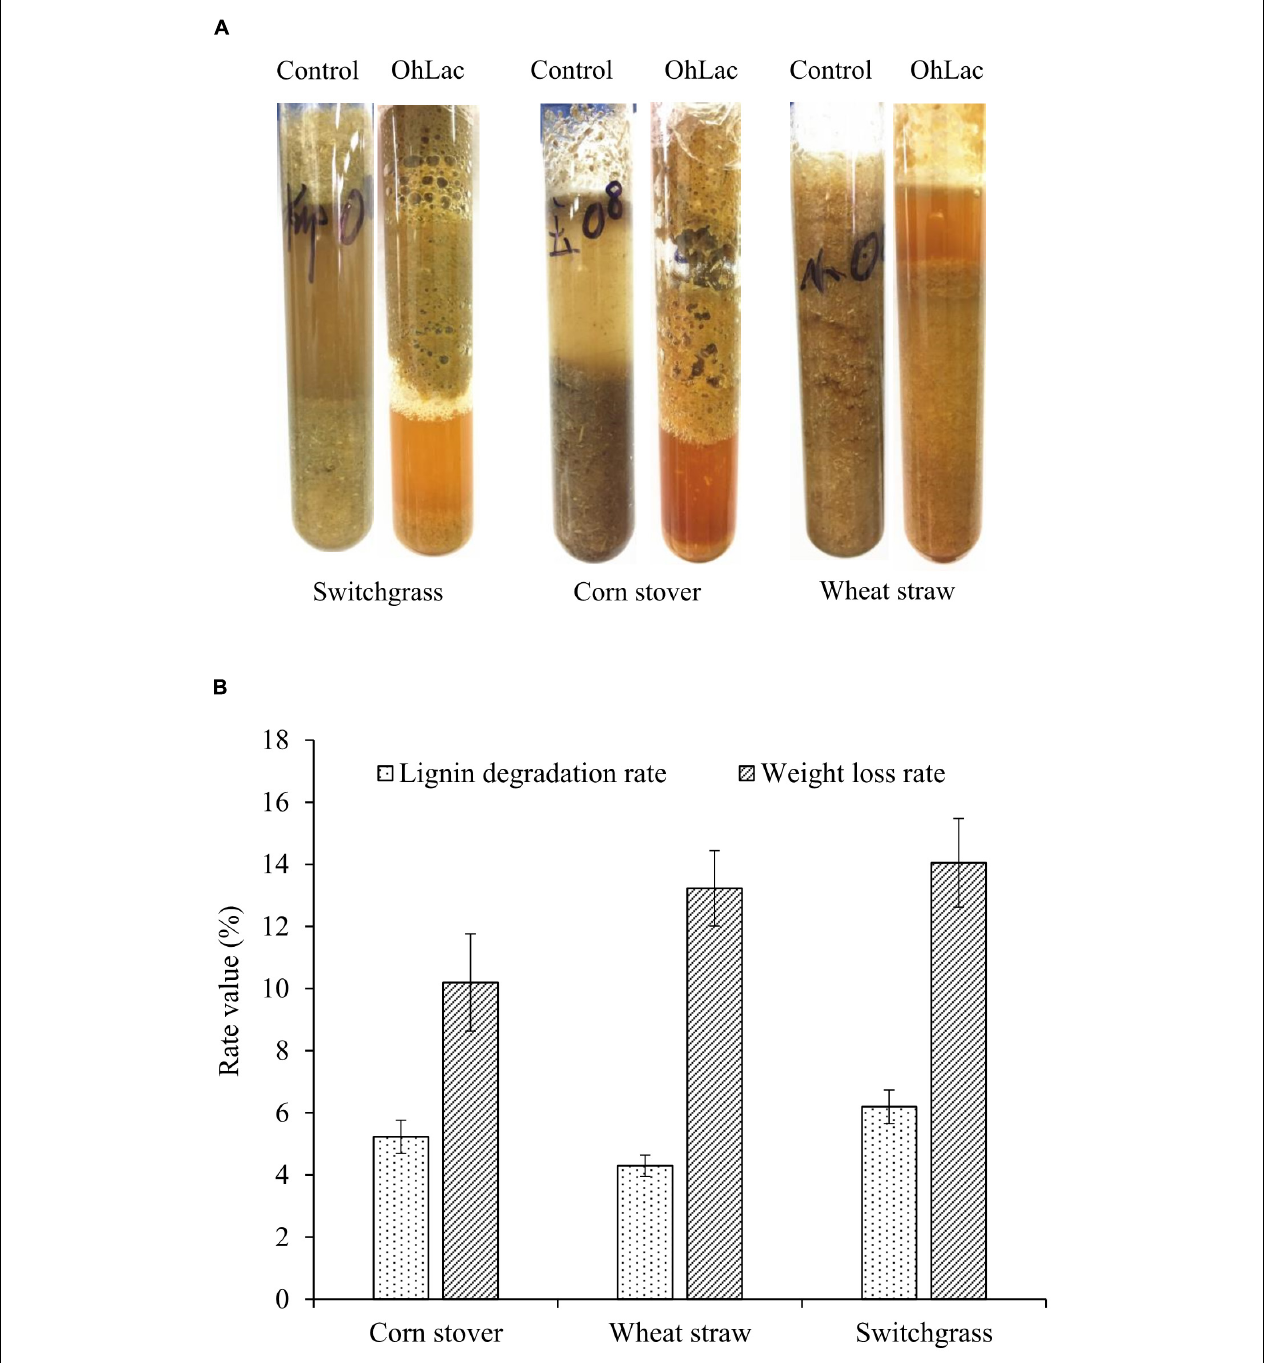
FIGURE 7 | The degradation of lignocellulose material by recombinant OhLac. (A) The appearance changes after degradation by OhLac. (B) The determination results of the lignin degradation rate and weight loss rate degraded by OhLac.